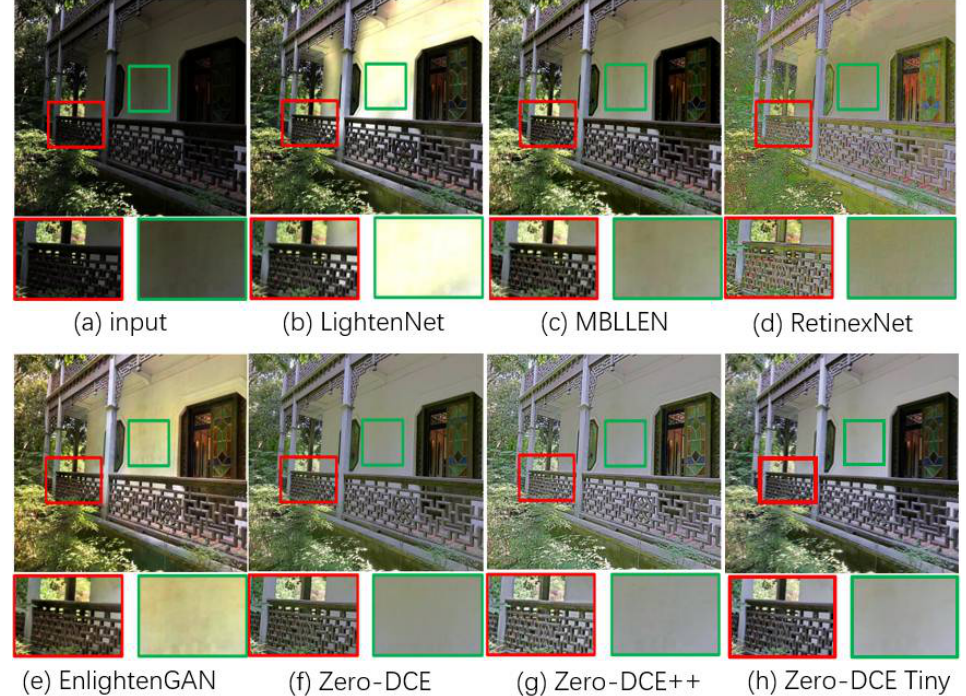
Figure 10. Visual comparison of Part 2 subset of SCIE dataset. Subfigure ( a ) shows the original input, subfigure ( b – h ) respectively show the enhanced image results through LightenNet [26], MBLLEN [8], RetinexNet [9], EnlightenGAN [27], Zero-DCE [5], Zero-DCE++ [6] and Zero-DCE Tiny methods.